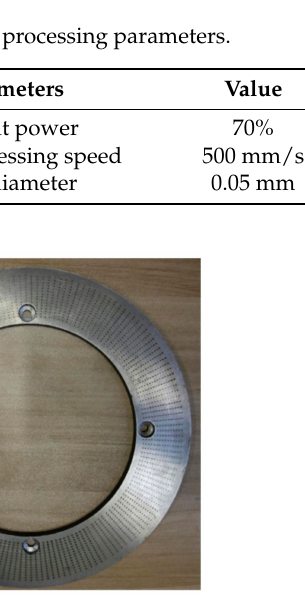
Figure 30. Textured surface of a friction